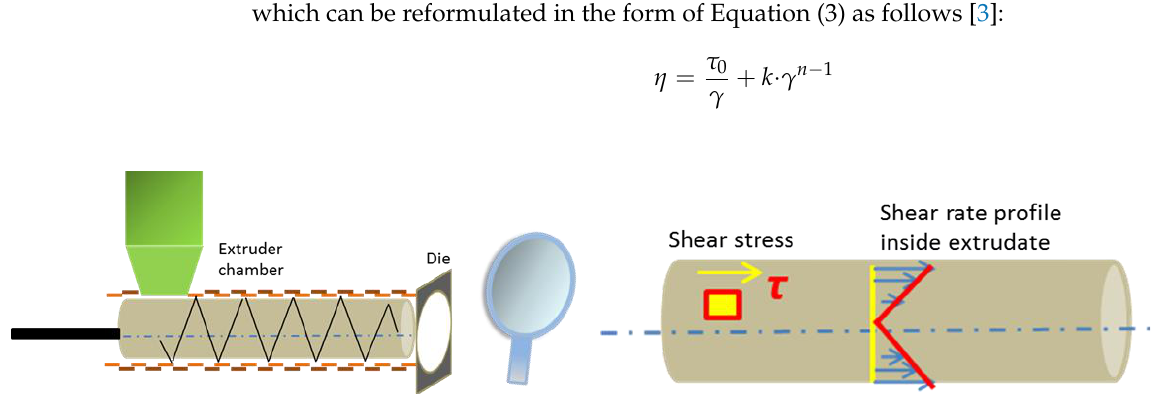
Figure 2. Shear stress (τ) applied to the extrudates during extrusion and shear rate profile on the Figure 2. Shearstress( τ extrudates.